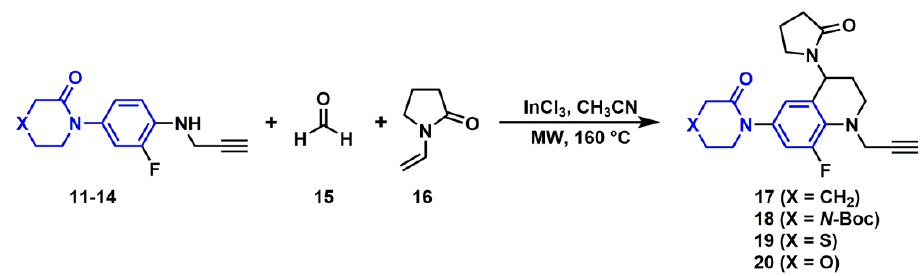
Table 4. Optimization of reaction conditions for the synthesis of compounds 17 – 20 .